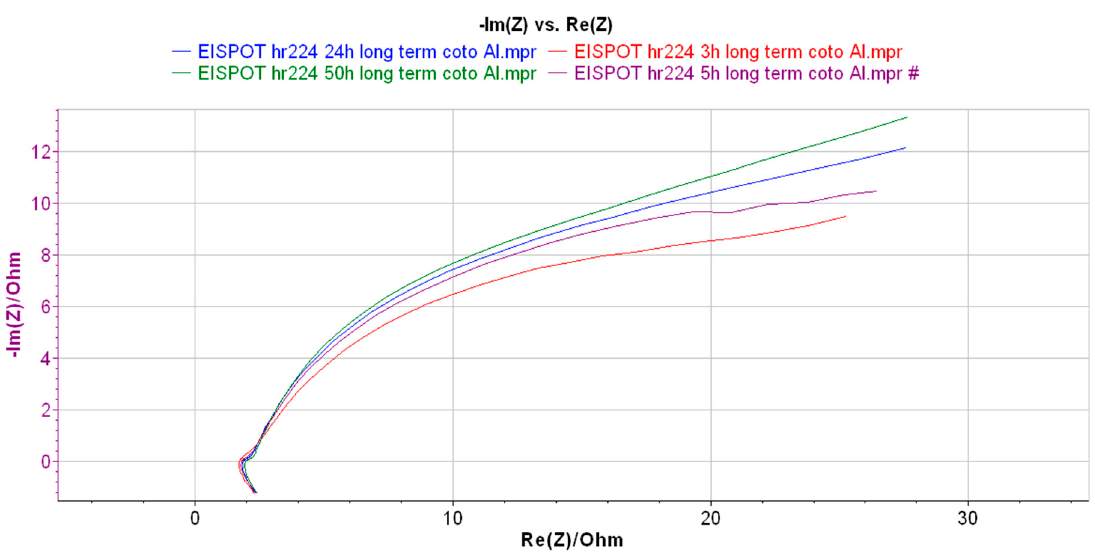
Figure 4. Nyquist plots of HR224 immersed in chloride molten salt at 3, 5, 24, and 50 h. Table 3. Electrochemical parameters obtained for EIS tests in HR224 alloy.